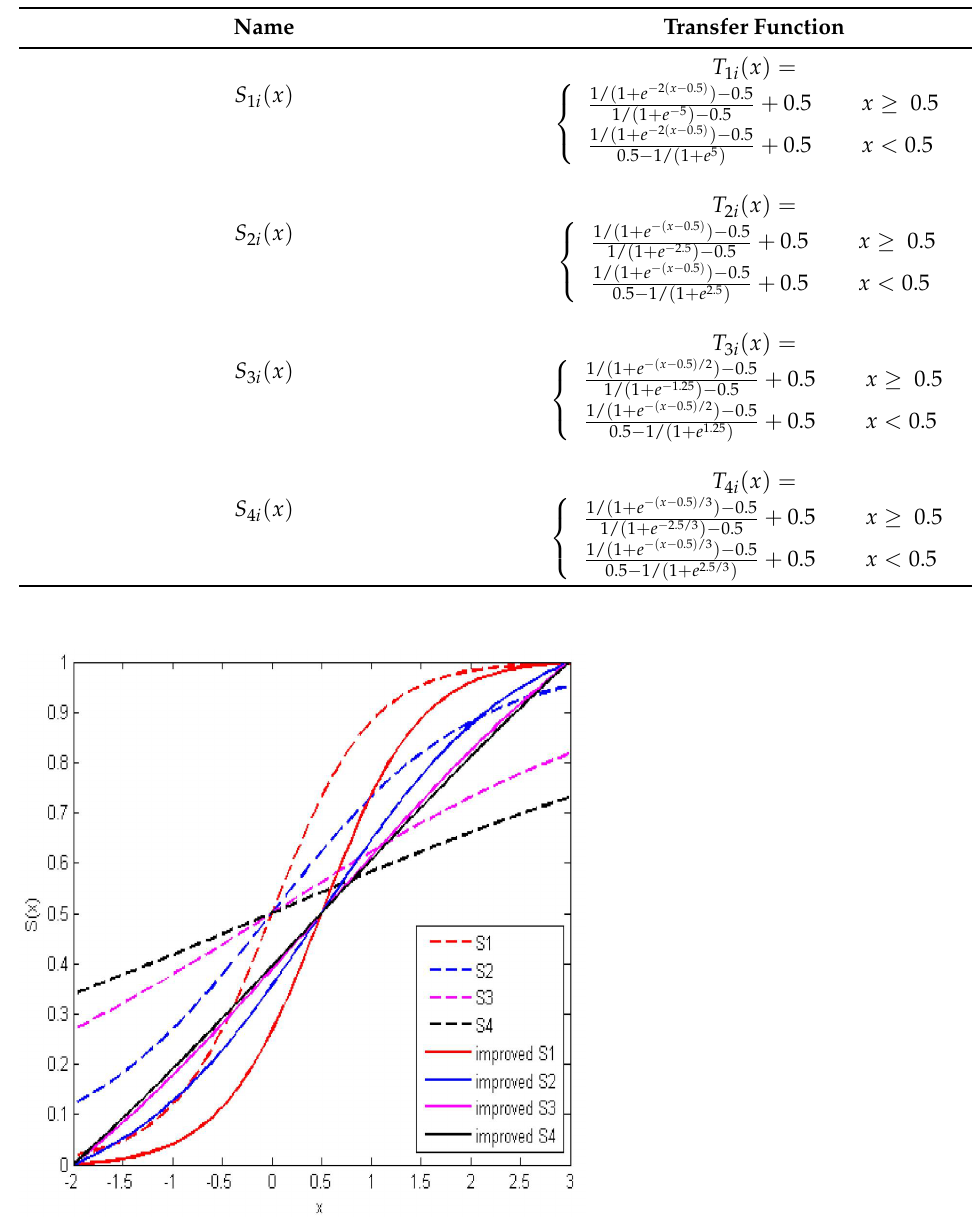
Figure 1. The original (the four dotted lines) and improved (the four solid lines) S-shaped families of transfer